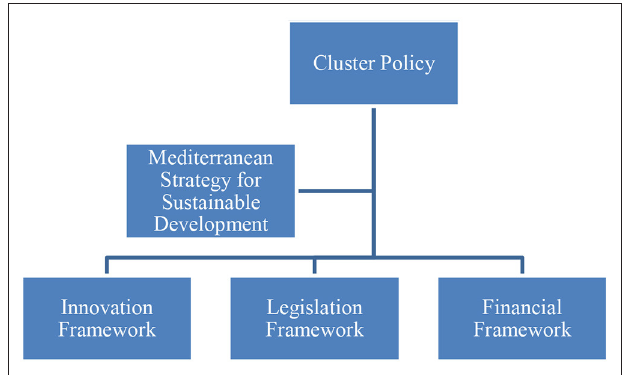
FIGURE 1 | Main constituents for a rational cluster